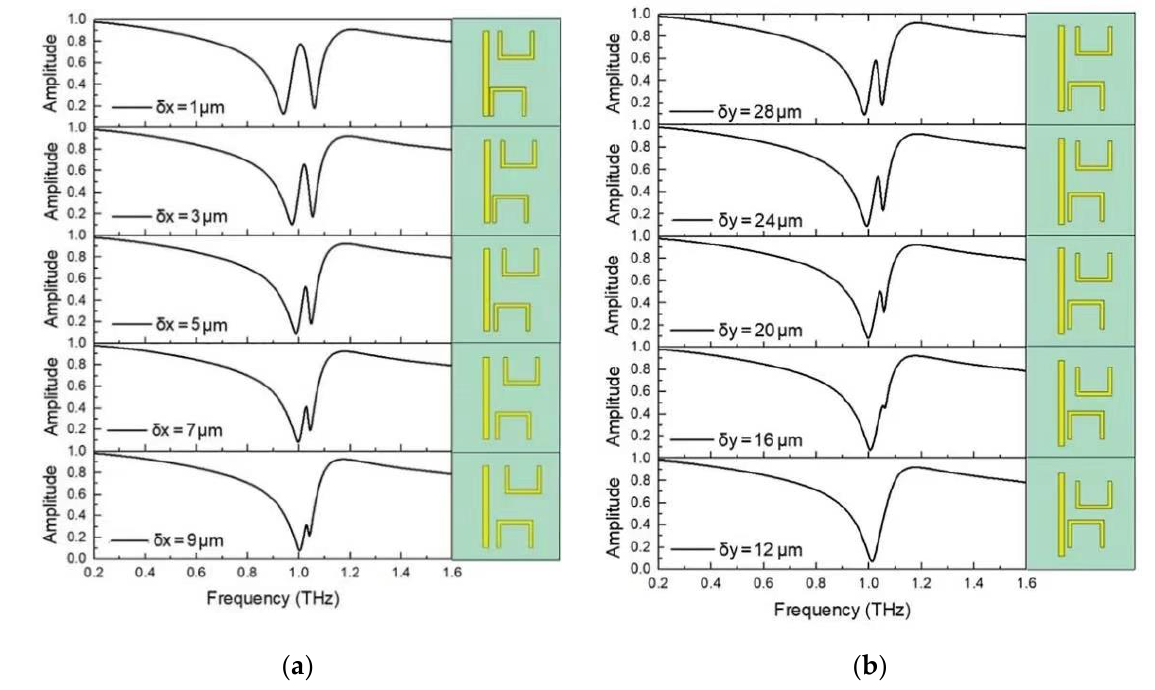
Figure 5. The influence of the asymmetric structural parameters on the transmission characteristics. ( a ) The transmission spectra with various coupling distances δ x between CW and USRs, the coupling distance δ x is smaller than that of the symmetric structure; ( b ) The transmission spectra with various coupling distances δ y between USR pairs, similar to the symmetric structure.